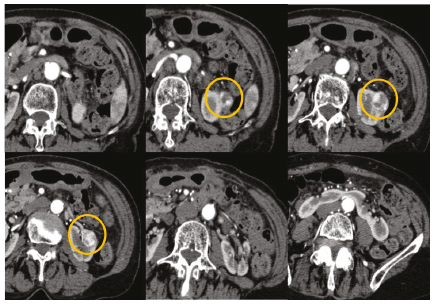
Figure 1: Contrast-enhanced CT. An enhanced tumor 20mm in diameter was observed in the upper pole of the left-side horseshoe kidney.